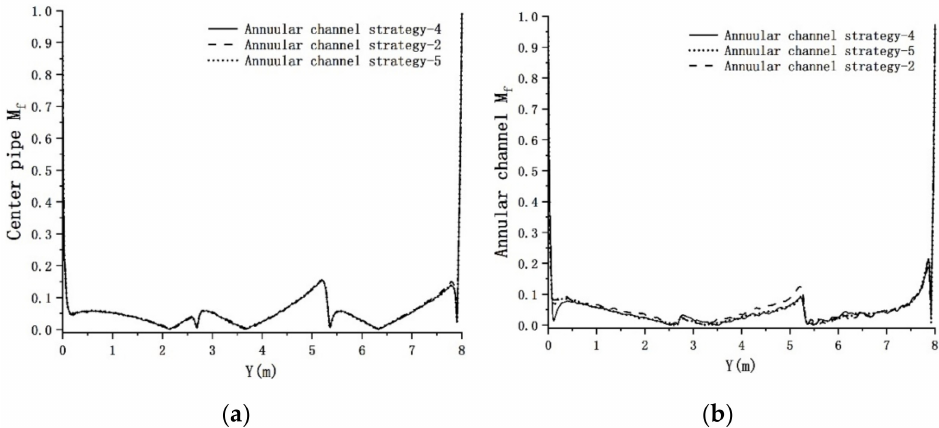
Figure 16. Non-uniformities for different annular channel strategies: ( a ) non-uniformity at the location of the Center pipe, ( b ) non-uniformity at the location of the Annular